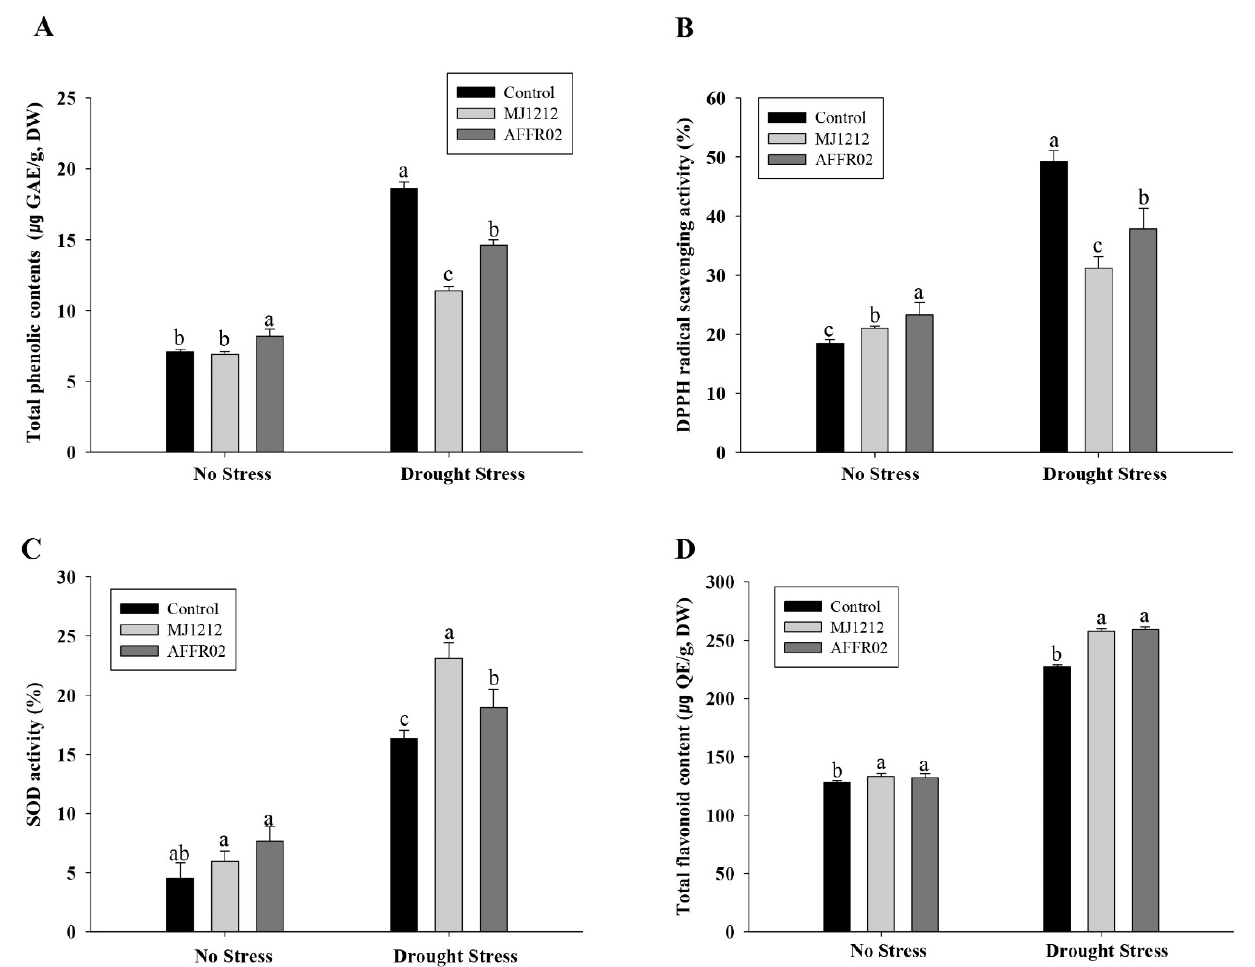
Figure 5. Effect of isolate AFFR02 and MJ1212 on ( A ) total phenolic content (TPC), ( B ) DPPH relative scavenging activity, ( C ) superoxide dismutase (SOD), and ( D ) total flavonoid content (TFC) of alfalfa plants under normal and post-drought stress. The values given are the mean of three replicates and error bars indicate the standard deviation. The bars presented with different letters are significantly different from each other by using Duncan’s multiple range test at p > 0.05.